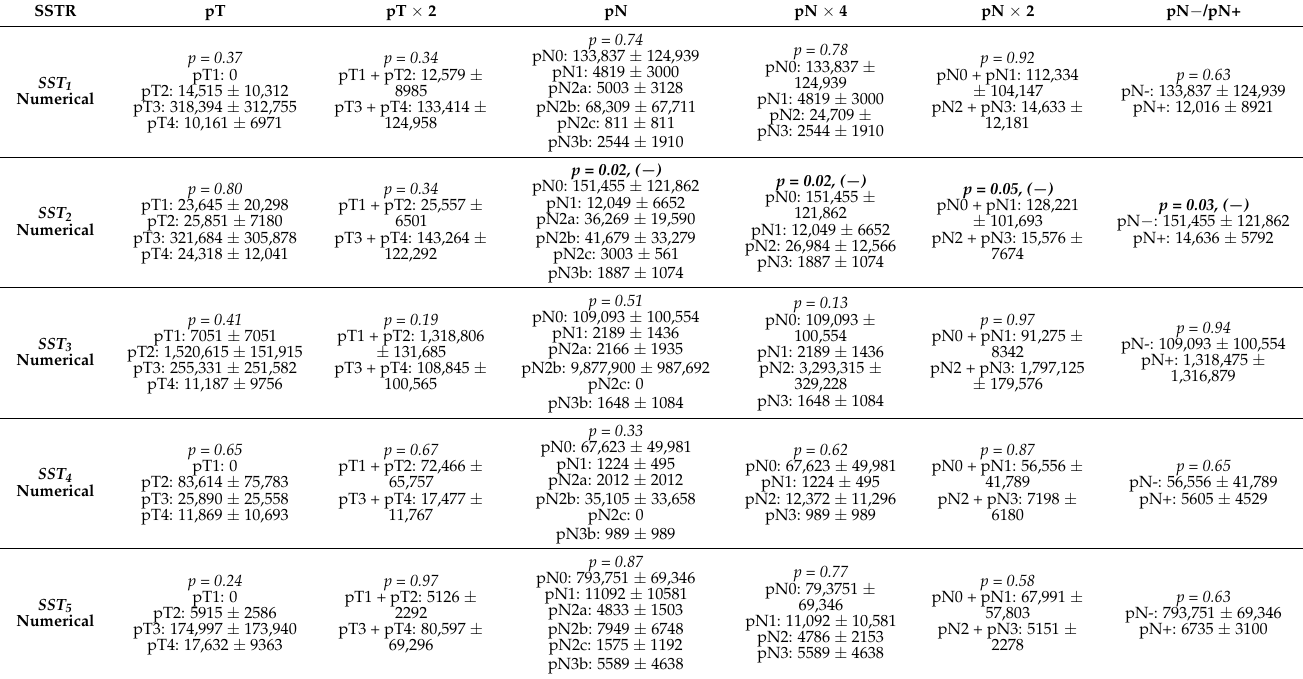
Table 2. In vivo relationship between SST-subtypes expression in OSCC and Staging data. SSTs Numerical expression is expressed as mean ± SD in each category. Nonparametric Kruskal-Wallis and U-Mann Whitney tests are used to analyze the relationship between SSTs expression and Staging